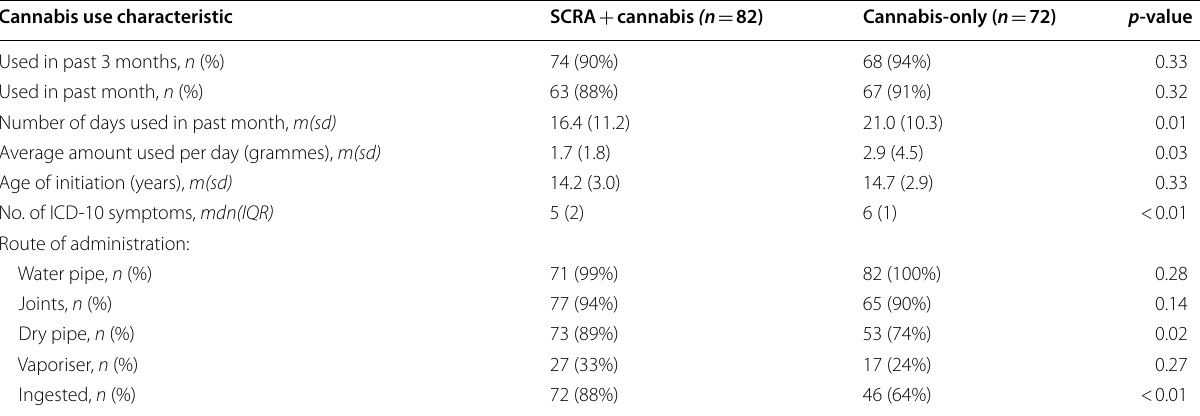
cannabis group and the cannabis-only group participants +